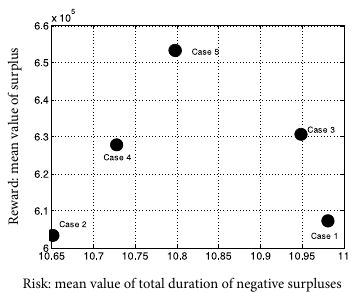
Risk: mean value of total duration of negative surpluses Fig. 9. The efficient frontier under Gaussian copula without catastrophe event